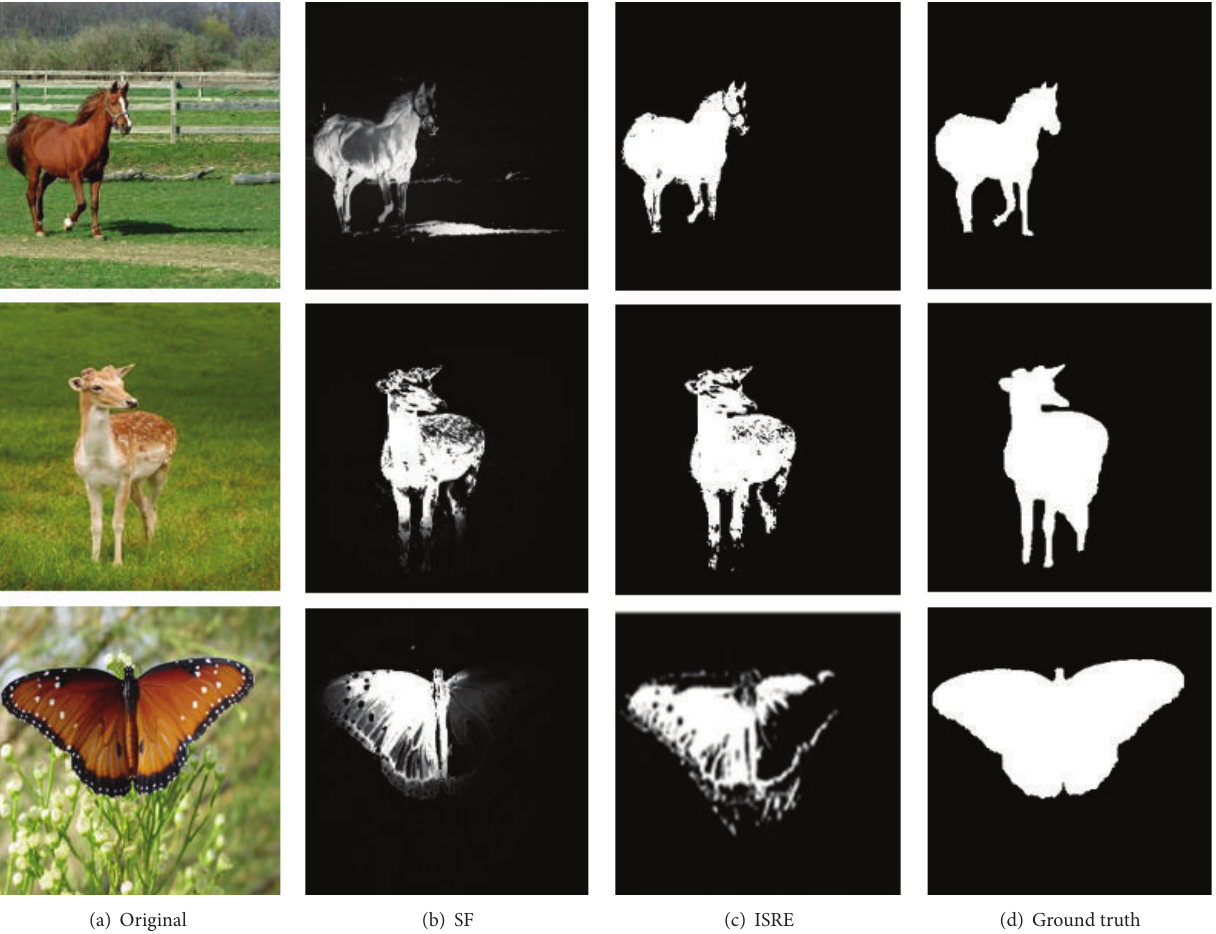
Figure 3: Effect contrast map of ISRE and